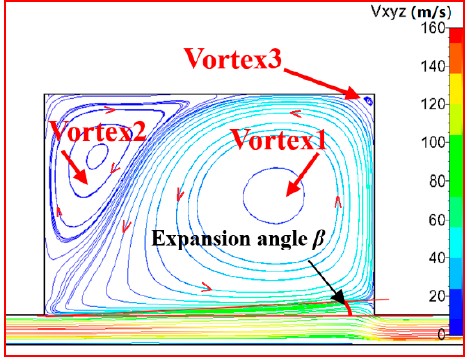
Figure 10. Internal streamline of air as working fluid.